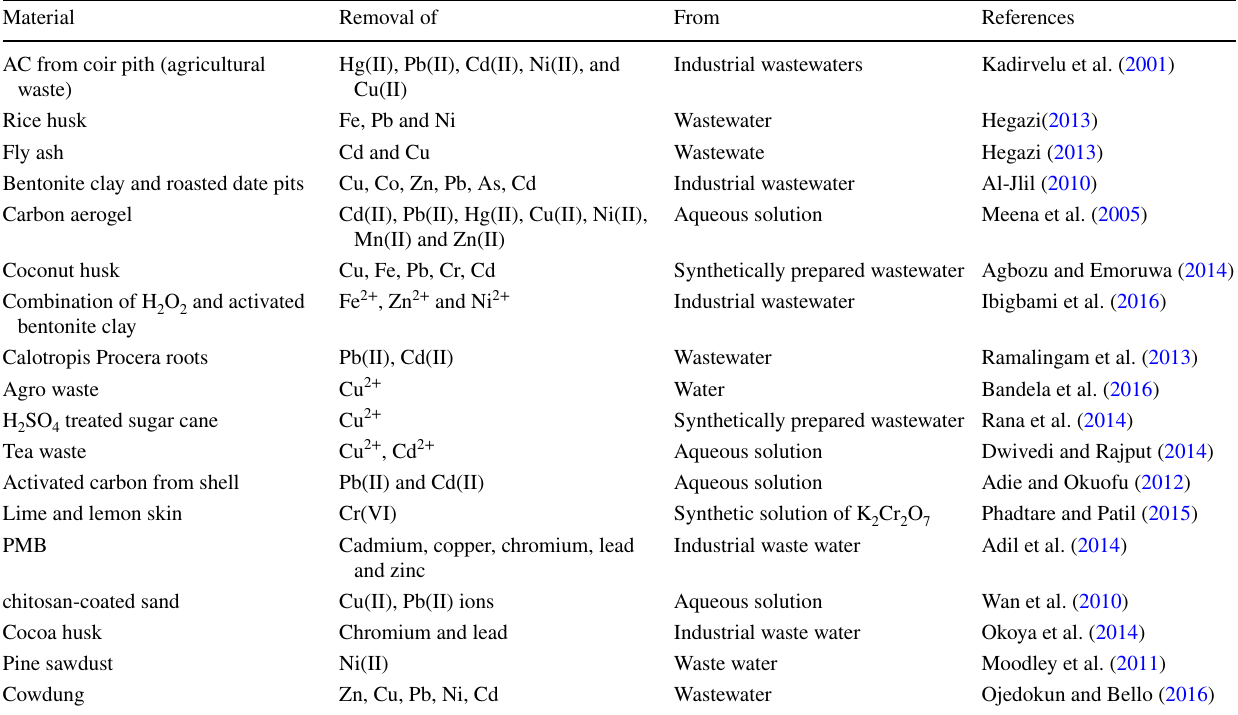
Table 10 Summary of low cost materials for the separation of heavy metals from water/wastewater Material Removal